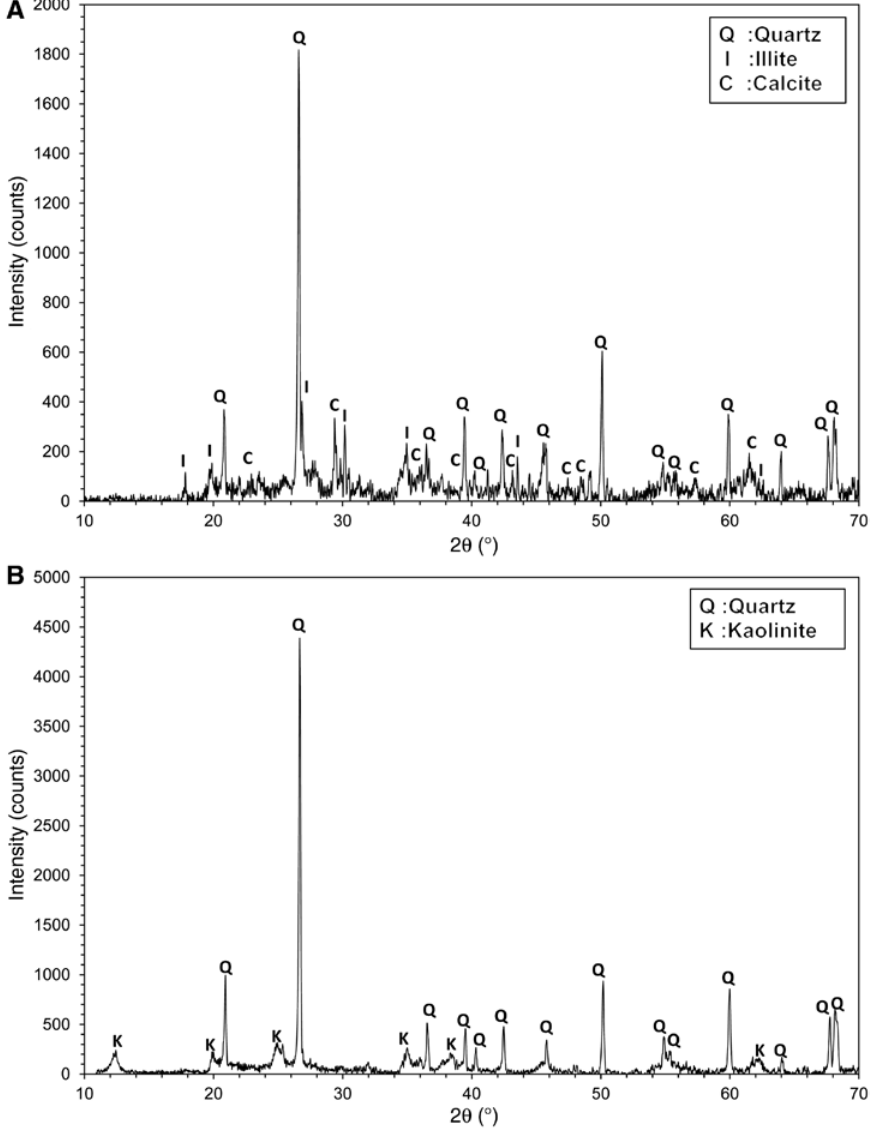
Figure 1: X-ray diffraction (XRD) pattern of soil samples (A) Soil A and (B) Soil